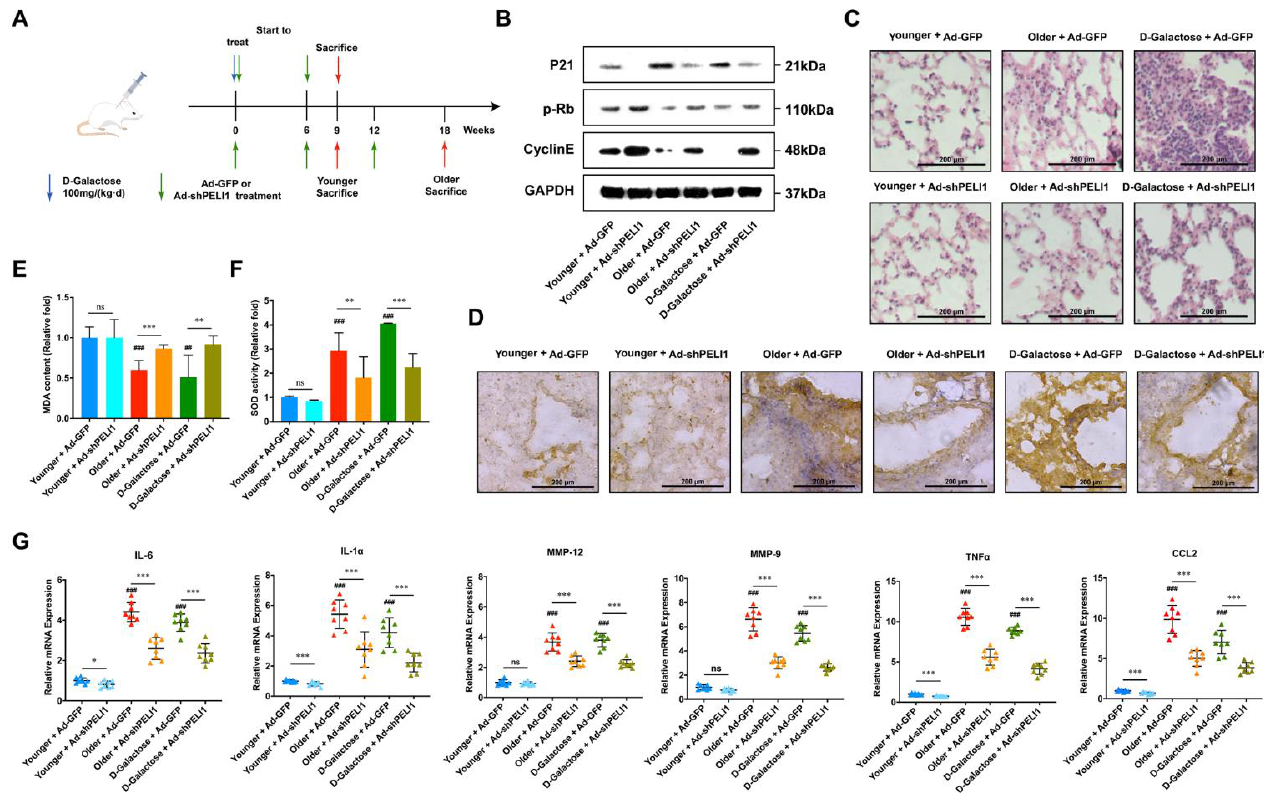
Figure 3. Silencing Pellino-1 inhibits lung cellular senescence via reduction of p21 and SASPs in vivo. ( A ) The strategy for studying the anti-senescence effects of silencing PELI1 in vivo. ( B ) Senescent mice showed an increase in p21, P16, and P53 and a decrease in p-Rb and Cyclin E, which could be reversed by silencing PELI1. ( C ) HE staining assay showed that silencing PELI1 reduced inflammatory infiltration in the pulmonary alveoli. ( D ) Immunohistochemistry showed that the bronchial wall thickening caused by senescence was reversed by silencing PELI1. Protein expression of p21 was also decreased by silencing PELI1. ( E ) MDA content of lung tissues. Silencing PELI1 relieved the reduction in MDA caused by senescence. ( F ) SOD activity of lung tissues. Silencing PELI1 relieved the increase in SOD activity caused by senescence. ( G ) The mRNA expression level of SASPs in lung tissue. Silencing PELI1 relieved the increase in SASPs caused by senescence. Data represents for E and F mean ± SEM; ## p < 0.01, ### p < 0.001 vs. (younger + ad-GFP group), * p < 0.05, ** p < 0.01, *** p < 0.001, ns for not significant, n = 8